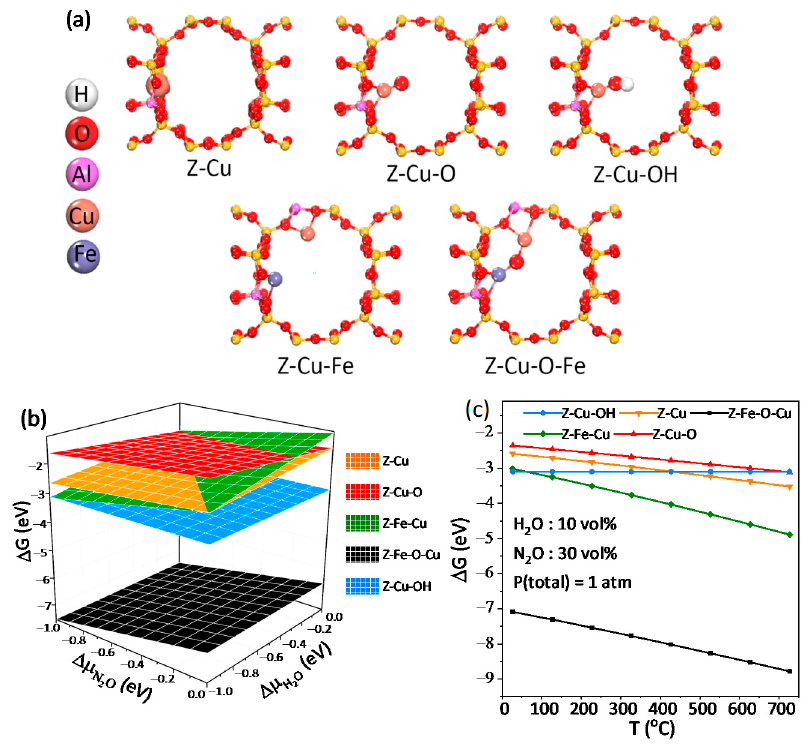
Figure 4. ( a ) Optimized structure models with diverse active-site motifs on the BEA zeolite; Z represents the BEA zeolite framework; the Al atom was located at the T5 site for the monomeric active site [18]; the T2 and T5 sites were chosen as the neighboring framework Al site based on previous studies [24]; ( b ) Gibbs-free energy of formation ( Δ G ) as a function of Δ μ N2O and Δ μ H2O (chemical potentials) for different active motifs at T = 270 °C; ( c ) Δ G as a function of temperature under N 2 O DMTM reaction condition of 10 vol% H 2 O, 30 vol% N 2 O and 1 atm pressure.